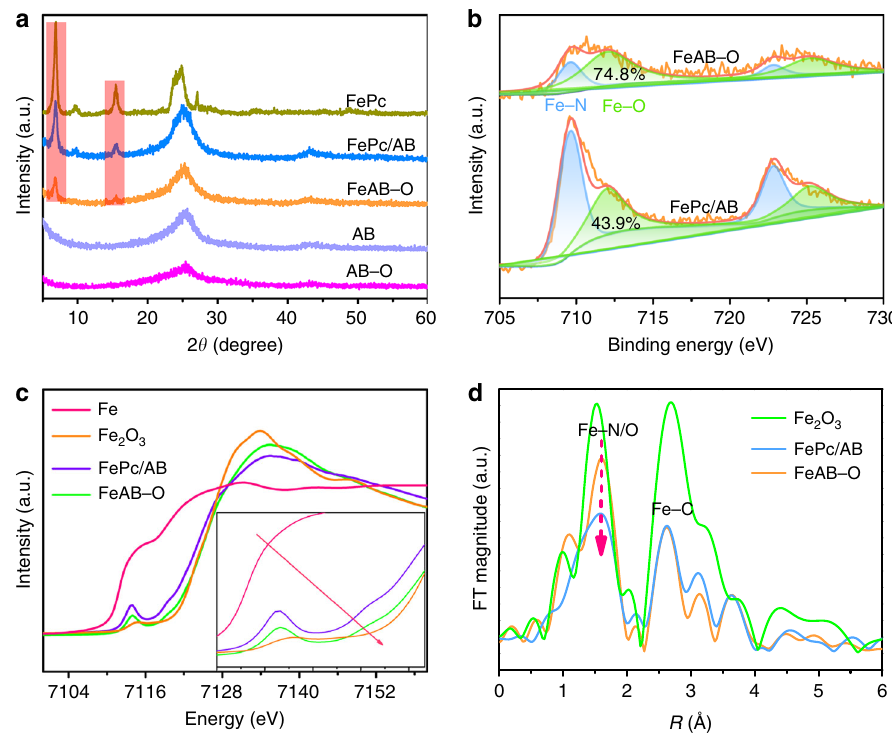
Fig. 2 Structure characterization. a XRD patterns of the pristine FeAB – O, FePc/AB, AB, AB – O, and FePc. b XPS Fe 2 p spectra of the FeAB – O and FePc/AB. c XANES spectra at Fe K-edge of the FeAB – O, FePc/AB, Fe, and Fe 2 O 3 . d Extended X-ray absorption fi ne structure (EXAFS) spectra of Fe K-edge in the FeAB – O, FePc/AB, and Fe 2 O 3